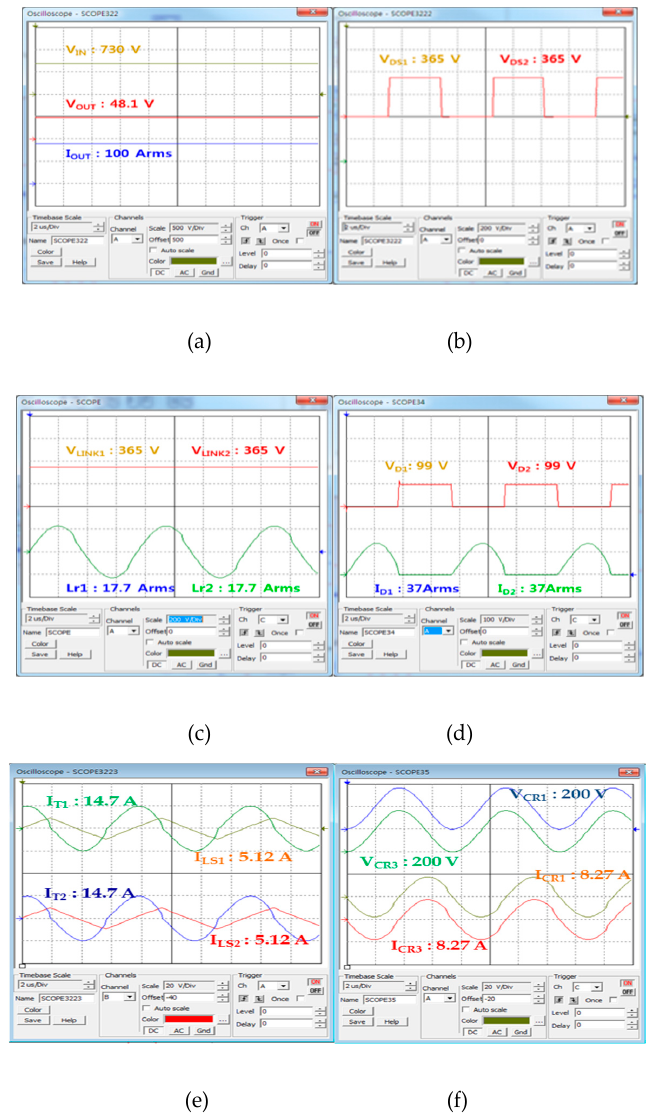
Figure 15. Simulation result of the proposed converter. ( a ) Input and output voltage and output current; ( b ) FET D–S waveform; ( c ) input cap. Voltage/resonant current waveform; ( d ) voltage/current of the rectifier diode; ( e ) ideal Transformer (T 1 ,T 2 )/shunt inductor(I LS1 ,I LS2 ) current waveform; ( f ) resonant capacitor Voltage(V CR1, V CR2 )/resonant capacitor current waveform(I CR1, I CR2 ).